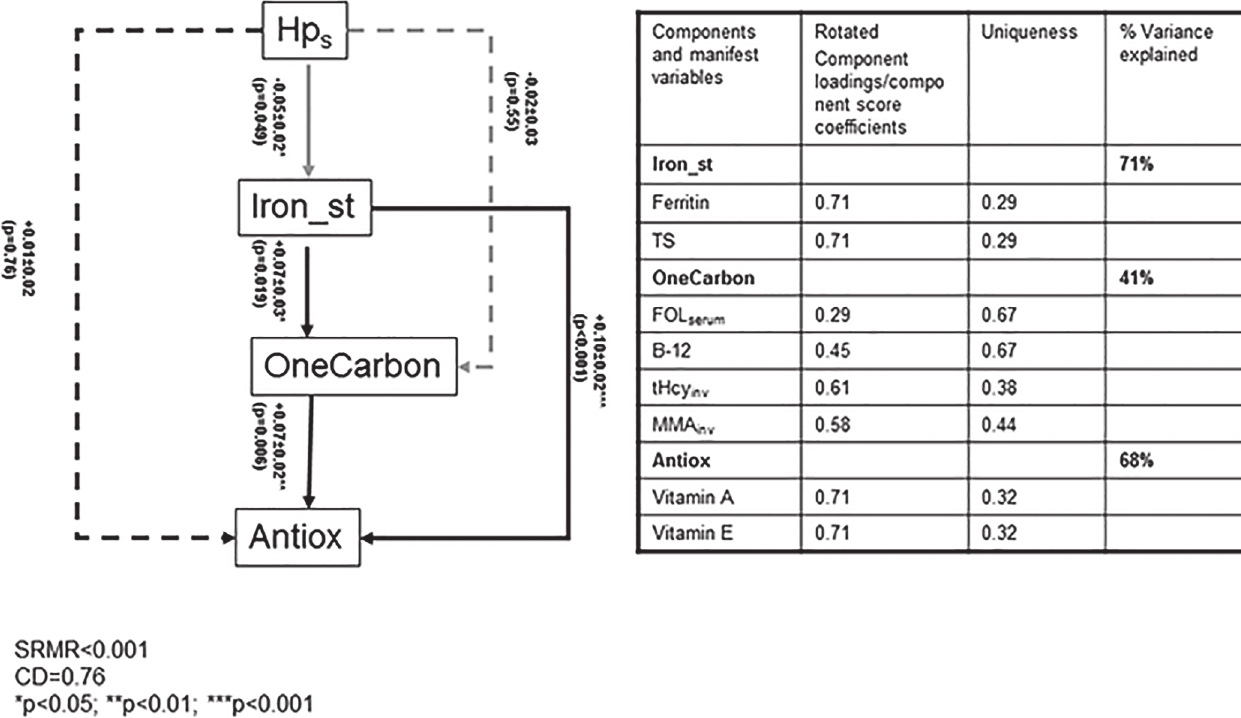
Fig 1. Structural equations model for associations between Hps, iron status, 1-C metabolites and markers of antioxidant status (N = 3,057): NHANES 1999 – 00. Footnote : solid lines (p < 0.05), dashed lines (p > 0.05), black line (+ association between biomarkers), gray line (- association between biomarkers). Exogenous variables in model with significant associations with each of the endogenous variables (p < 0.05) are listed below: Hps equation: Age (+), Black vs. White (+), Mex Am vs. White (+), Other vs. White (+), education (-), poverty income ratio(-), smoking(+), supplement use (-); Iron_st equation: Age(+), Women vs. men (-),energy(-), alcohol(+),sodium(+), BMI(-);OneCarbon equation: Age(-), Women vs. men (+), Black vs. White (+), Mex Am vs. White (+),alcohol (-), fiber (+), supplement use Antiox equation: Age(+), Women vs. Men (-), Black vs. White (-), Mex Am vs. White (-), Other vs. White (-), alcohol (+), fiber (+), supplement use (+), cholesterol (+), SBP (+), medical conditions (+).